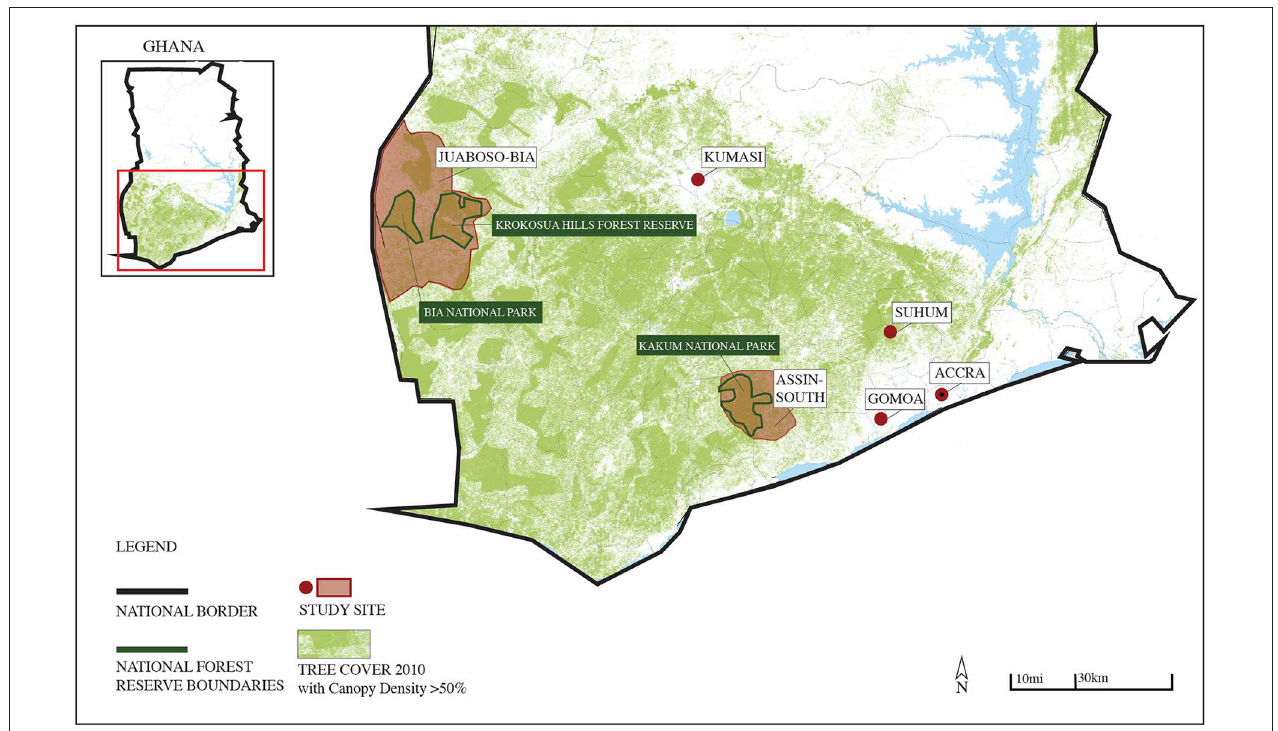
FIGURE 1 | Map of study sites in Ghana. Source: World Resources Institute (2019) and author’s own creation.